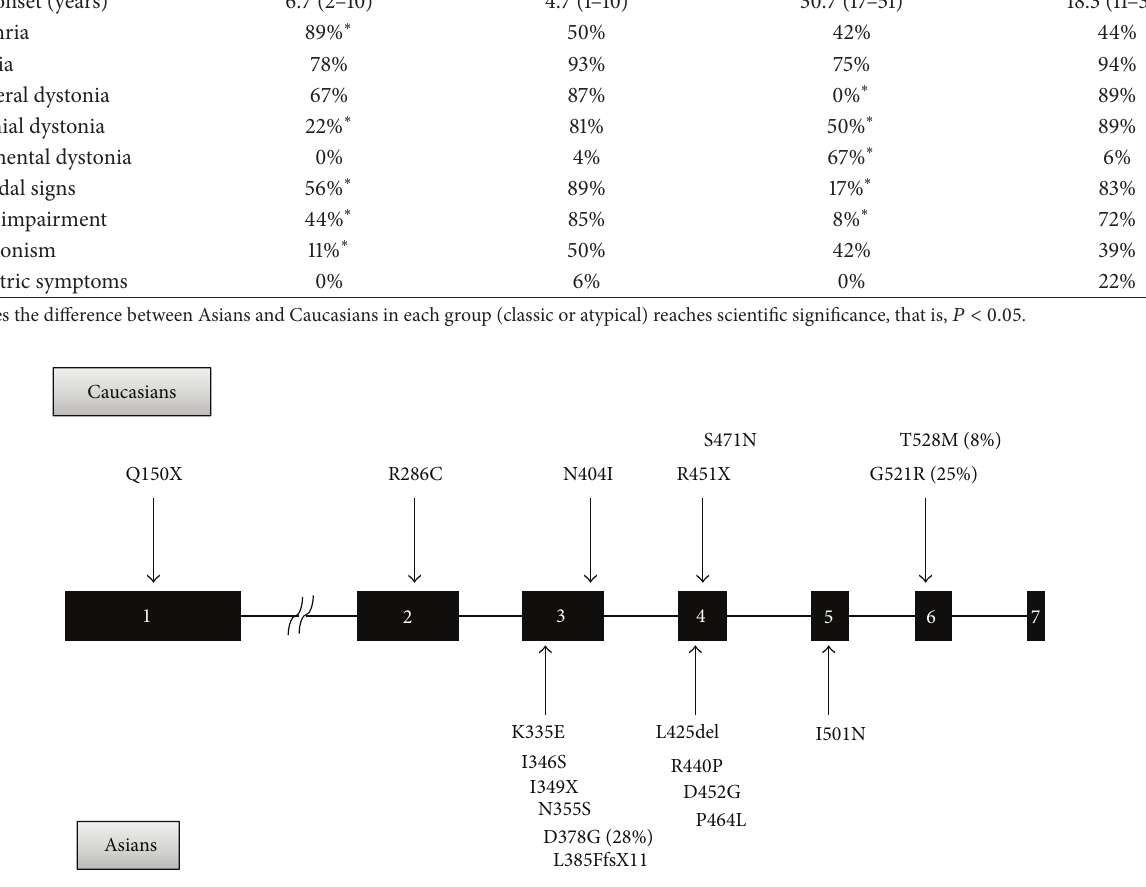
Figure 3: Common mutations of PANK2 gene in Asians and